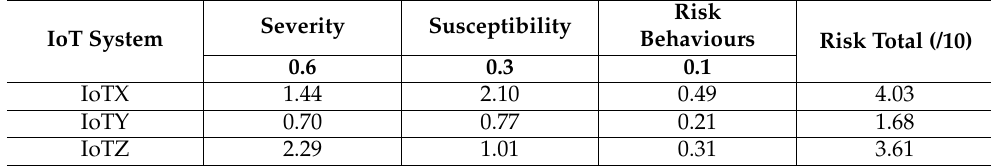
Table 9. Screenshot of the application of MCDA to evaluate the risk of three different IoT